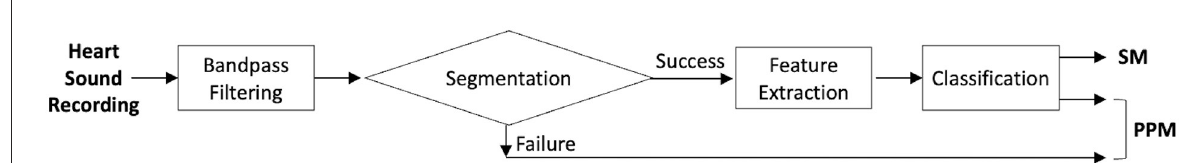
FIGURE1 Algorithm flowchart.